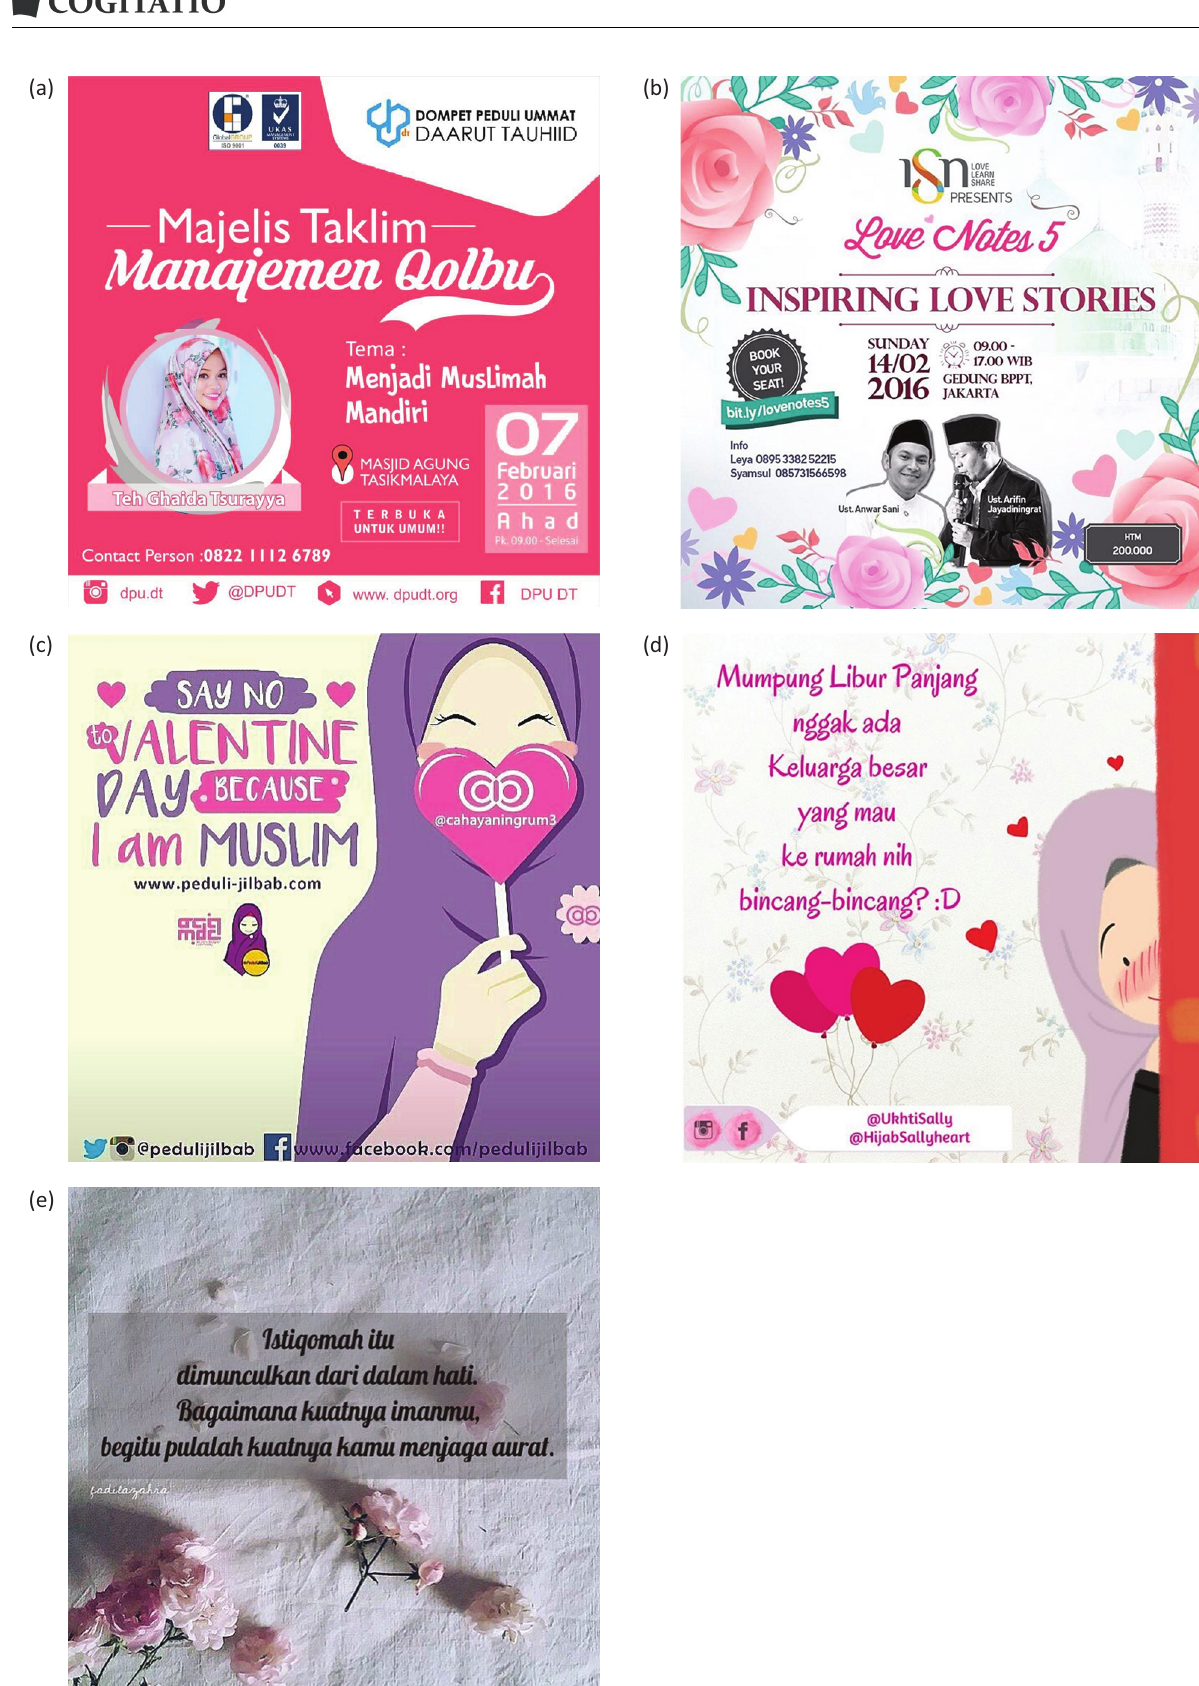
Figure 1. A set of images from the Instagram accounts of (a) Tasikmalaya Hijabers (TH), (b) Hijabers Community (HC), (c) Peduli Jilbab (PJ), (d) Ukhti Sally (US), and (e) Dunia Jilbab (DJ), posted on 7 February